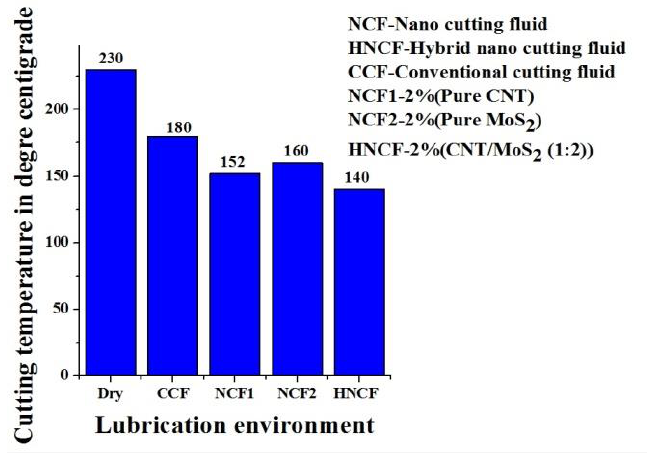
Figure 4. Variation of cutting temperature with different lubrication environment (CS=80 m/min, FR=0.161 mm/rev and DOC =0.5